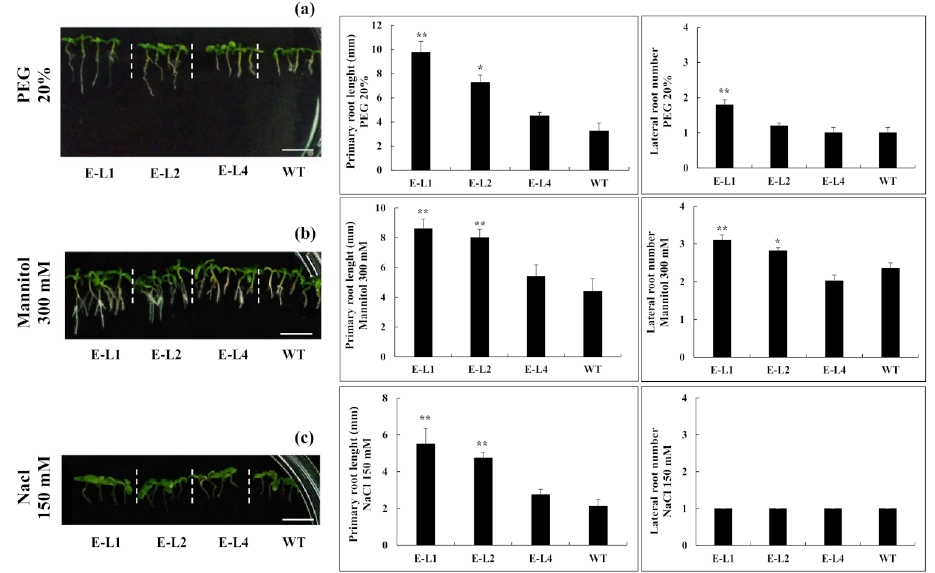
Figure 7. Root growth of transgenic tobacco lines overexpressing the TgERF1 gene and WT seedlings under various stress treatments, which consisted of ( a ) 20% PEG, ( b ) 300 mM mannitol, and ( c ) 150 mM NaCl. Bar: 1 cm. In these experiments, three-day-old seedlings were transferred to the osmotic and saline treatments and grown for seven days. The primary root length and lat- eral root numbers were recorded at seven days after the transfer. Each experiment consisted of 16 seedlings/line and three repetitions. Bars represent the mean value ± SEM of three independent assays. Significant differences were determined by ANOVA followed by Dunnett’s test. * * Significant at p < 0.01 and * at p <